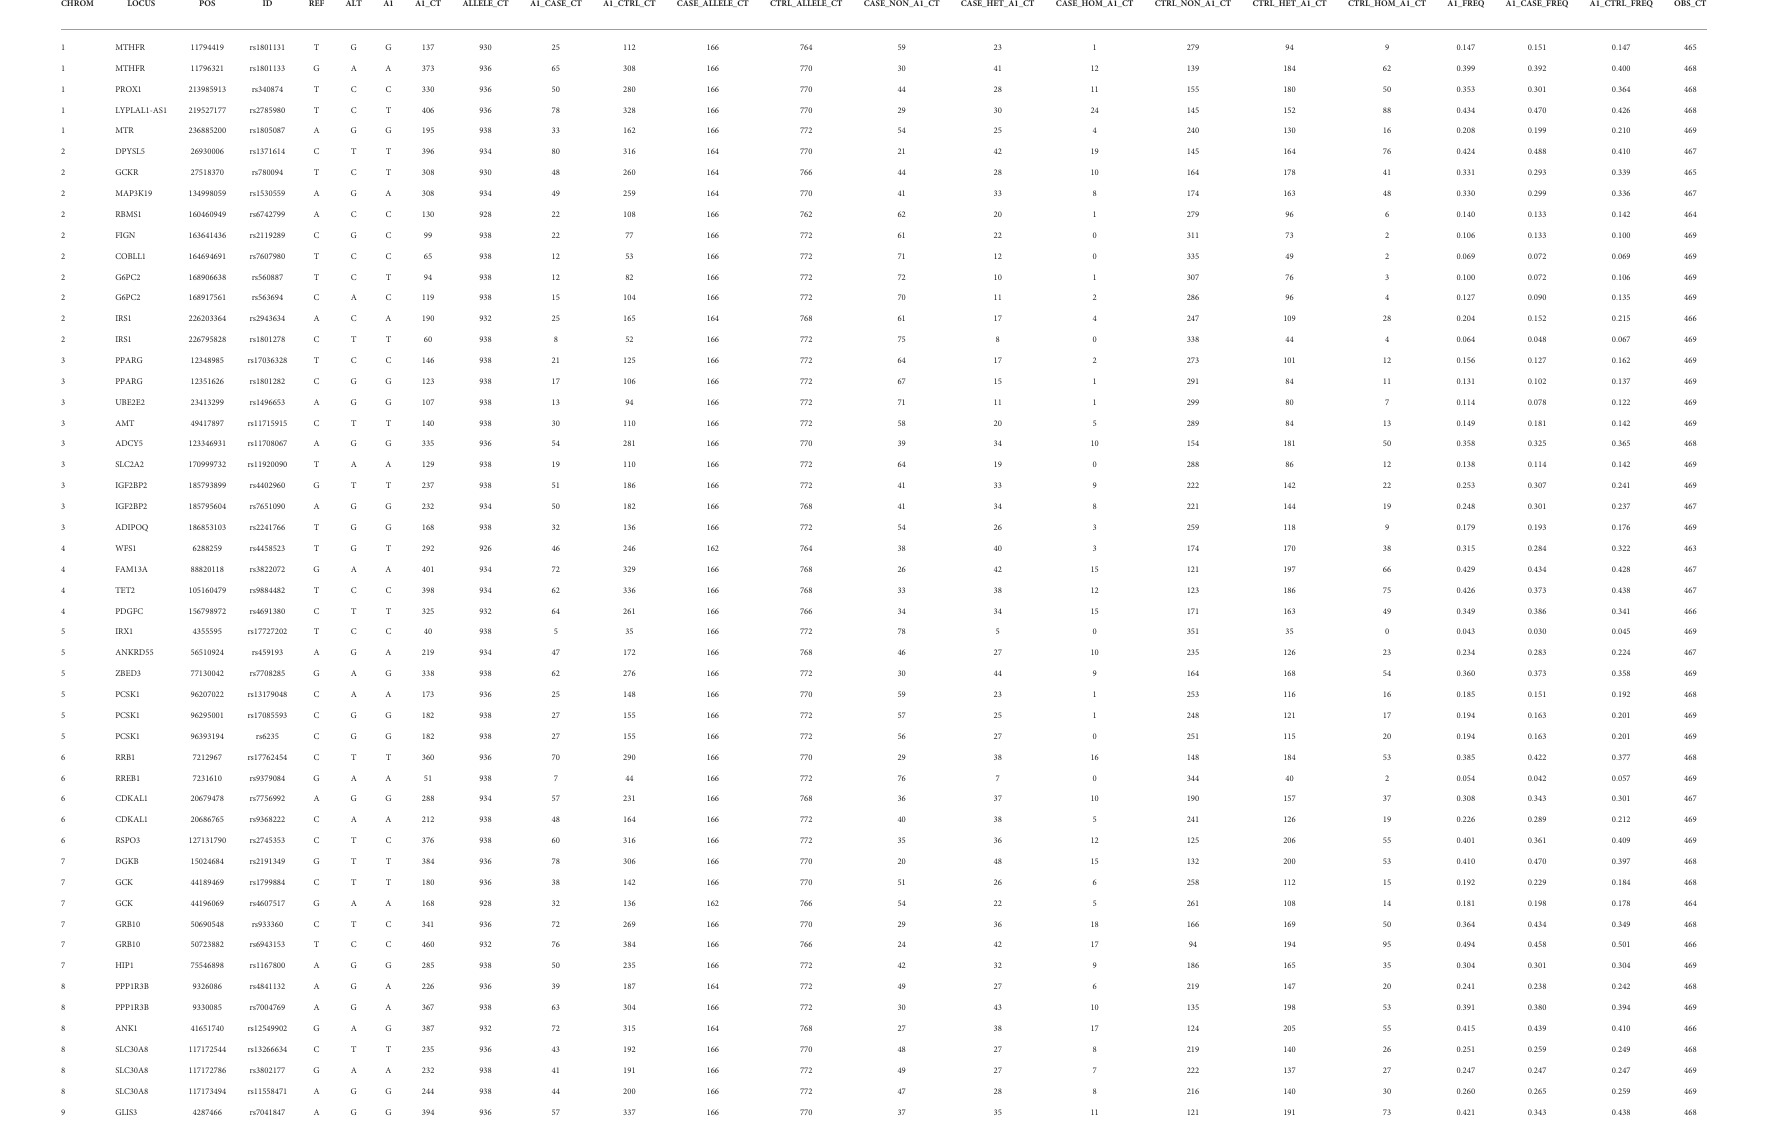
TABLE 2 HIS Characteristics of variants.